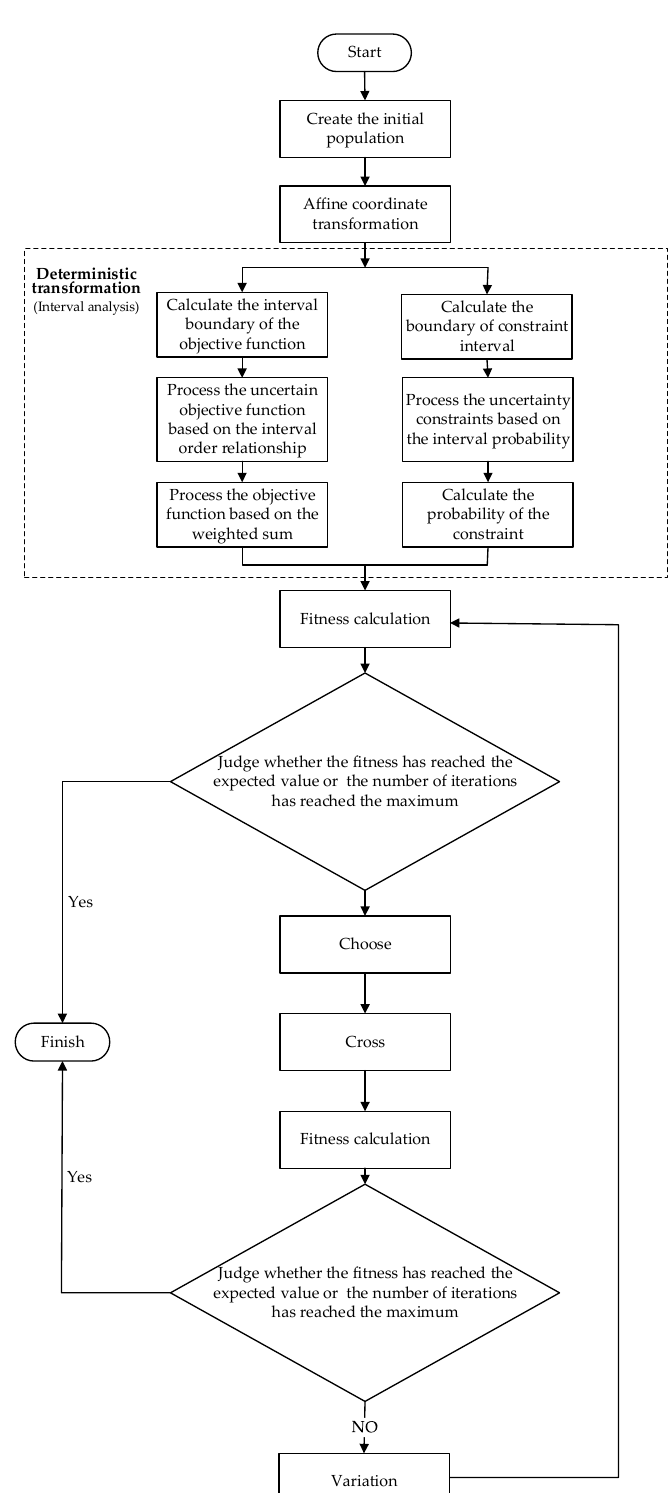
Figure 3. Solution